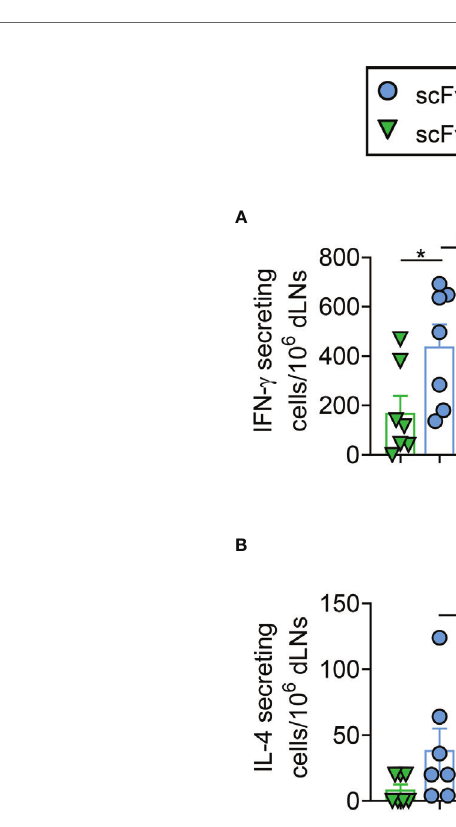
FIGURE 4 | scFv a MHCII -PfRH5 D NL DNA vaccination induced rapid IFN- g and IL-4 T cell responses. (A, B) BALB/c mice were vaccinated once with 50 µg i.m./EP as indicated or NaCl control. Draining lymph nodes (dLN, left) or spleens (right) were harvested at day 5 post-vaccination. IFN- g secreting cells (A) or IL-4 secreting cells (B) after stimulation with PfRH5FL protein for 48 h were analyzed (mean ± SEM). n = 7 for scFv a NIP -PfRH5 D NL and scFv a MHCII -PfRH5 D NL, n = 6 for PfRH5 D NL, and n = 4 for NaCl group, *p < 0.05, ***p < 0.0001, two-tailed Mann-Whitney